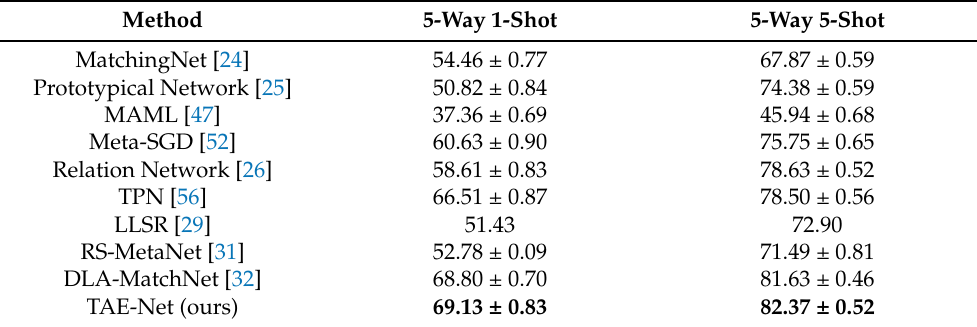
Table 4. Classification accuracies and standard deviations (%) of 5-way 1-shot and 5-way 5-shot on the NWPU-RESISC45 dataset. The best results per scenario are marked in bold.